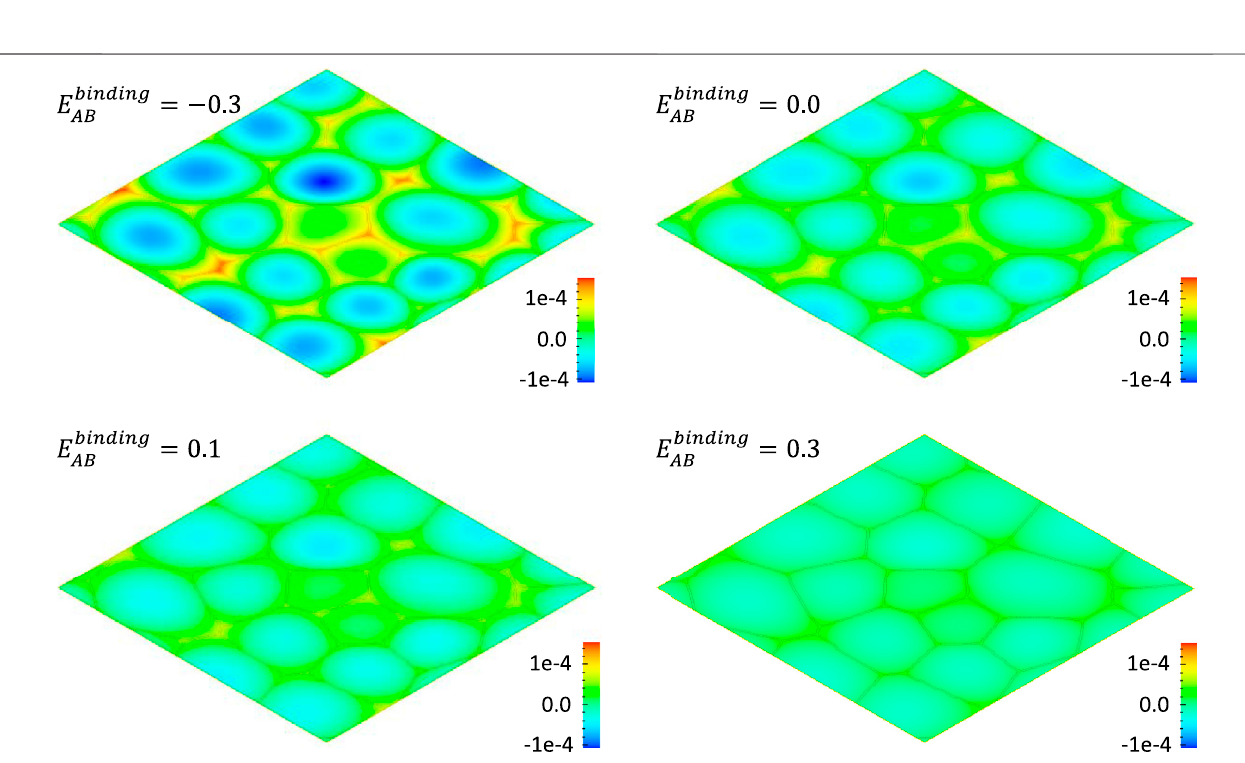
FIGURE 6 | Effect of AB binding energy E binding AB on the distribution of solute concentration change Δ c A at time t (cid:2) 8 . 17s. E binding AB has the unit of